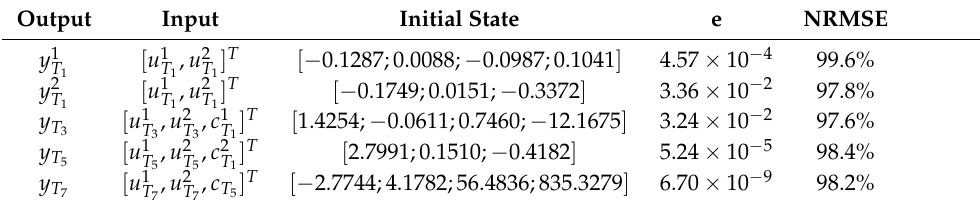
Table 2. Parameters of